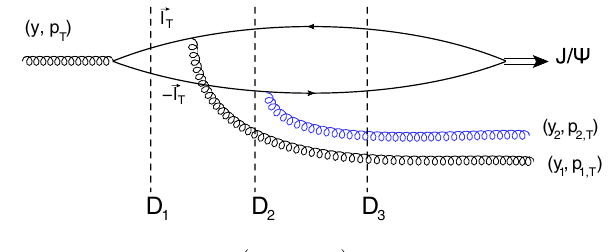
Fig. 8 The diagram for I